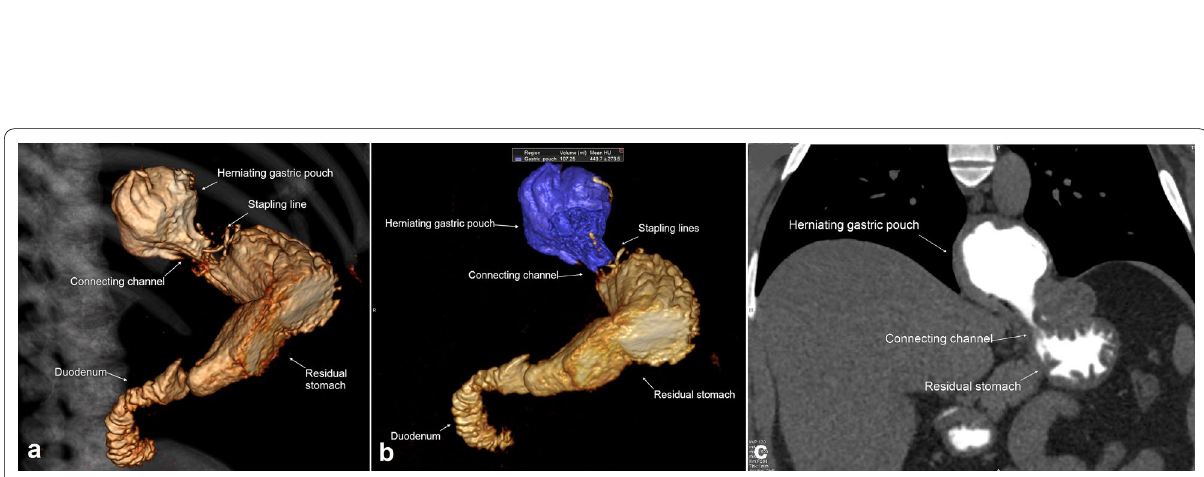
Fig. 3 Hiatus hernia complicating butterfly gastroplasty with symptomatic GERD. Semitransparent 3D volume rendered image ( a ) accurately depicts the anatomical changes including intact stapling line with sizeable hiatal hernia containing the whole gastric pouch. The herniated gastric pouch is dilated as well, its volume 107 ml ( b ). Coronal reformatted image ( c ) clearly demonstrates the herniated gastric pouch into posterior = mediastinum well extending above diaphragm through widened esophageal